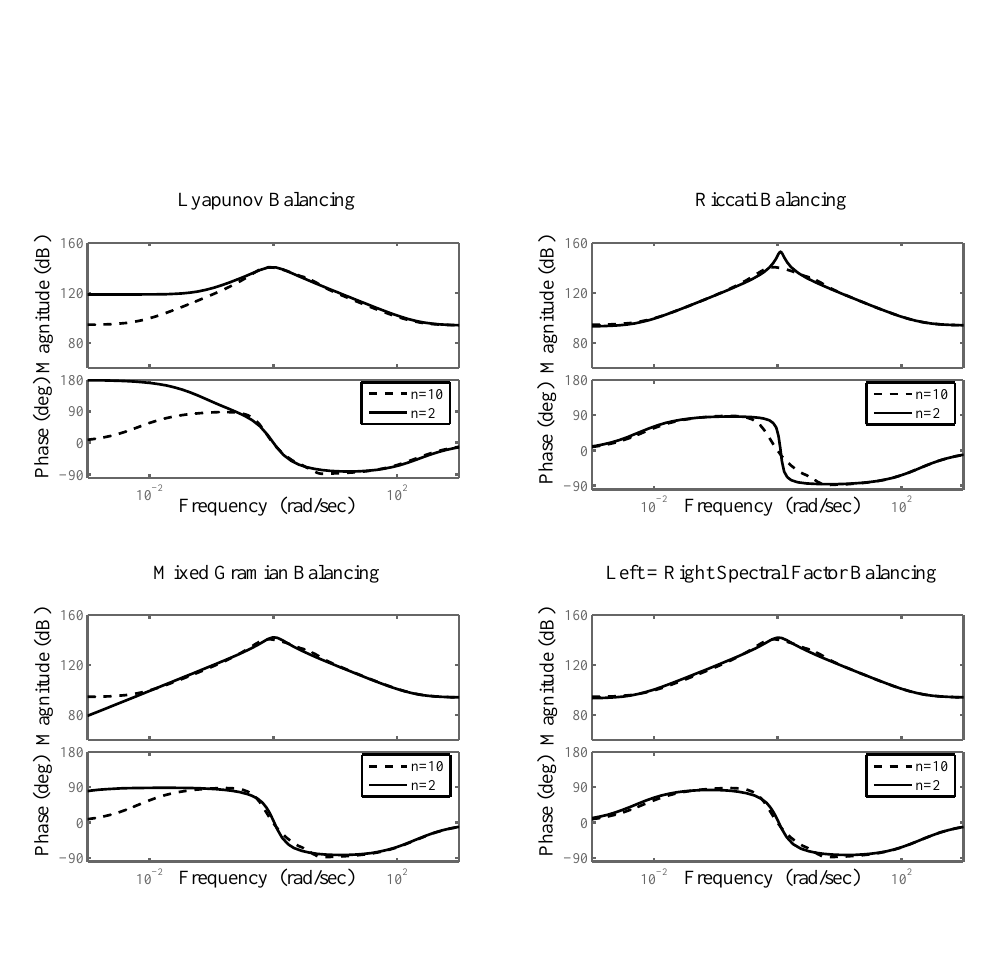
Figure 3: Bode plot of the difference between the original system of order n = 10 and reduced order system of order n = 2 using the different balancing